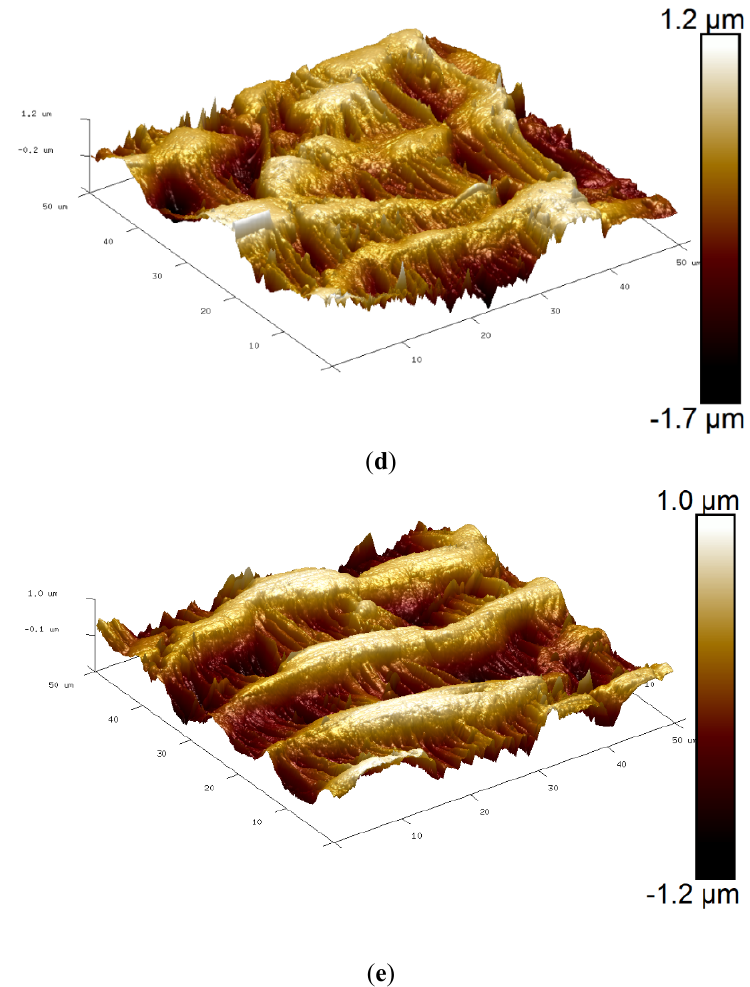
Figure 10. Three-dimensional AFM images of ( a ) virgin membrane, ( b ) fouled membrane from pilot run, ( c ) fouled membrane from lab test with untreated leachate, ( d ) fouled membrane from lab test with treated leachate, and ( e ) membrane cleaned with UV+H 2 O 2 .